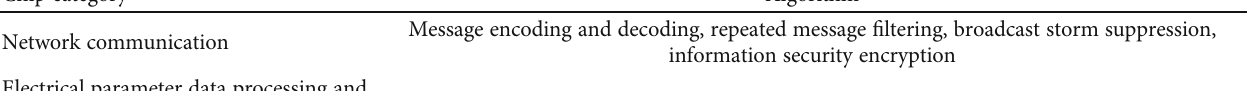
Table 2: Electric power chip algorithm library. Algorithm information security